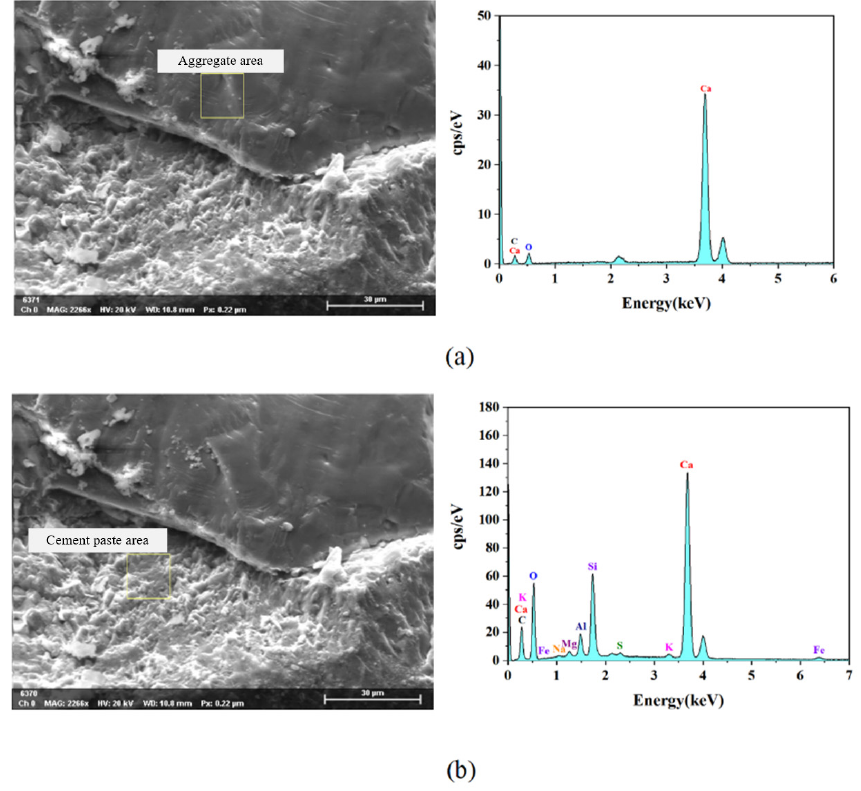
Figure 15. EDS spectrum of ITZ ( a ) aggregate area; ( b ) hardened cement paste area. Table 3. Contents of each element in energy